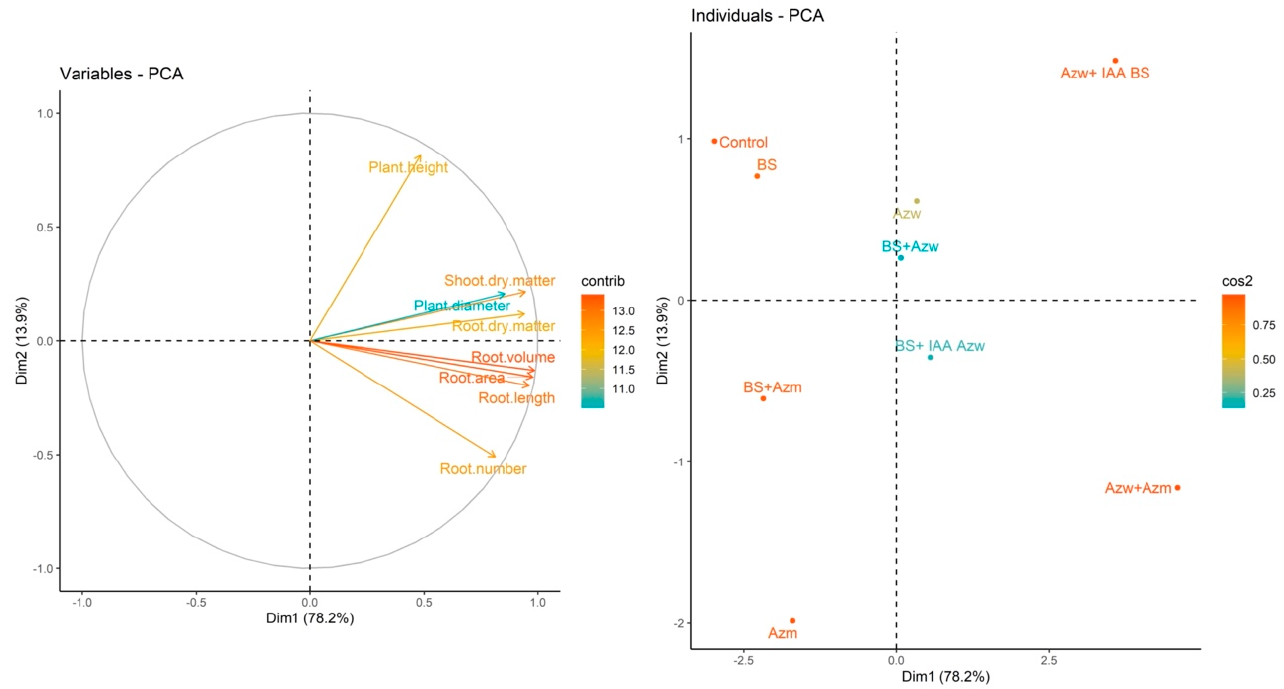
Figure 5. Main component analysis (PCA) for variables and treatments (individuals). Values on axes 1 and 2 represent the percentage of total variance explained by axes for the Entire genotype .